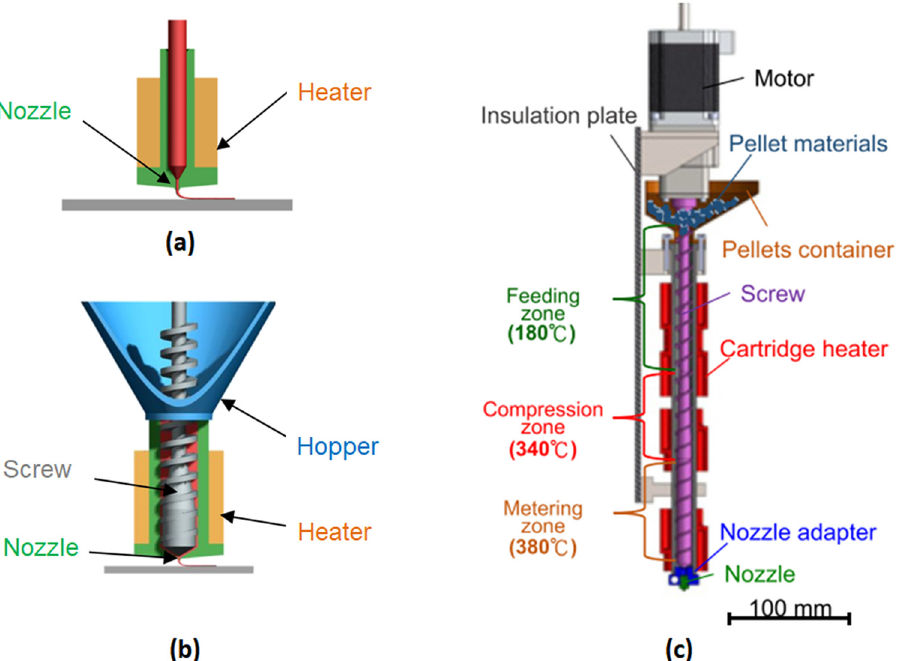
Figure 7: ( a ) Filament - based FDM nozzle; ( b ) screw - based FDM nozzle; ( c ) con fi guration and geometry of screw - based FDM nozzle unit. Adopted from ref. [ 85 ] with modi fi